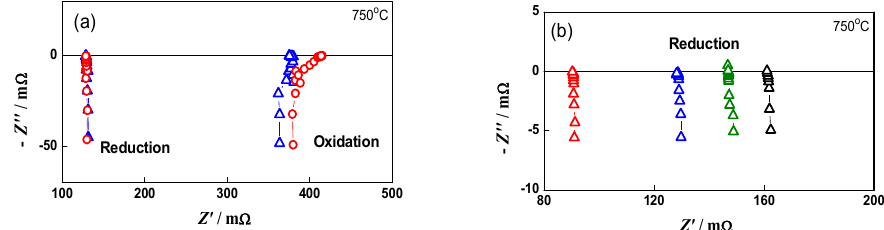
Figure 4. Impedance diagrams of bare anode during redox cycling: ( a ) two consecutive redox cycles—Cycle 7 ( ∆ ) and Cycle 8 ( ○ ); ( b ) reduced state after four different redox cycles—Cycle 2 ( ∆ ), Cycle 7 ( ∆ ), Cycle 11 ( ∆ ), Cycle 18 ( ∆ ).